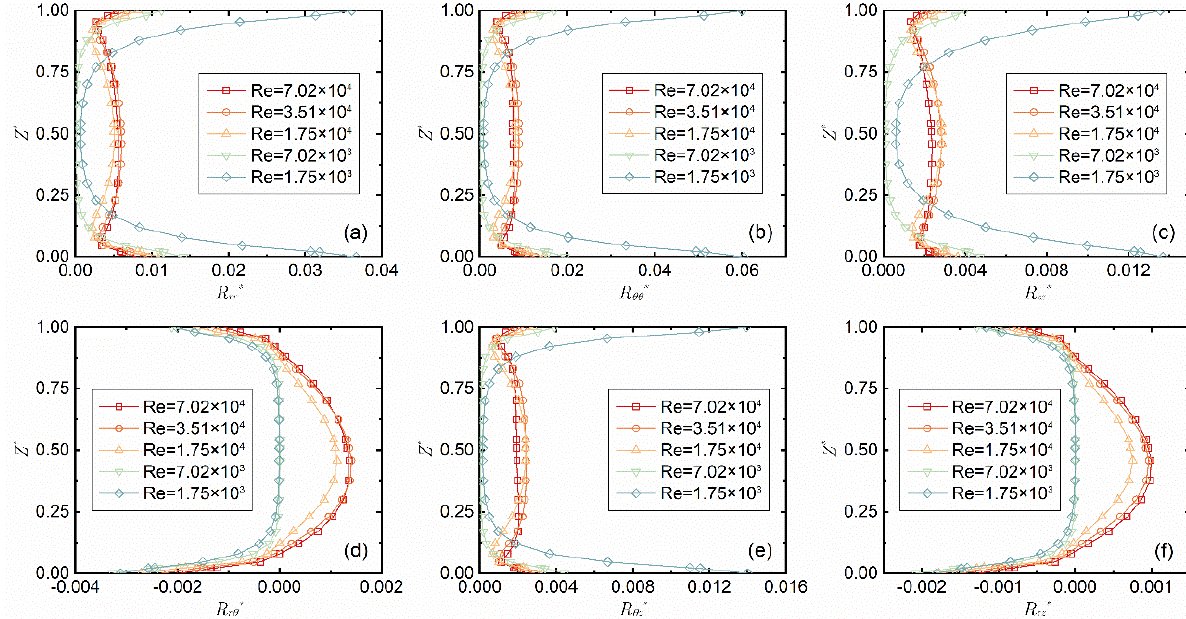
Figure 6. Change of the six components of the Reynolds stress tensor ( a – f ) with Re when G = 0.02 and r * = 0.8.